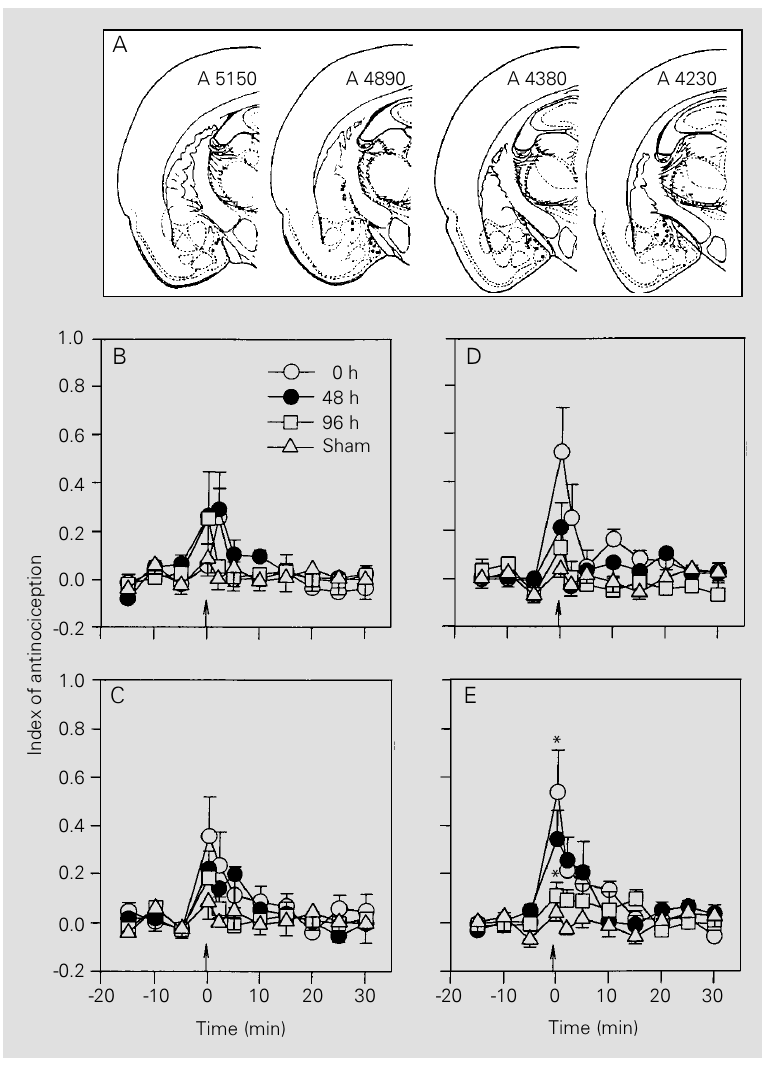
* Figure 1 - Antinociceptive effects of stimulating the medial or central nuclei of the amygdala. (A) Cross sections taken from the atlas of K(cid:246)nig and Klippel (32), at the indicated AP levels, showing the location of the sites stimulated during experiments for the determination of current thresholds. The remaining graphs show the time-course of the effects of stimulating the medial (B and D) or the central (C and E) nuclei of the amygdala for 15 or 30 s, respectively, on three different occasions at 48-h intervals. N = 4 for the curves of graph C and 5 for the remaining graphs. *P<0.05 compared to sham-stimulated animals (Duncan test).